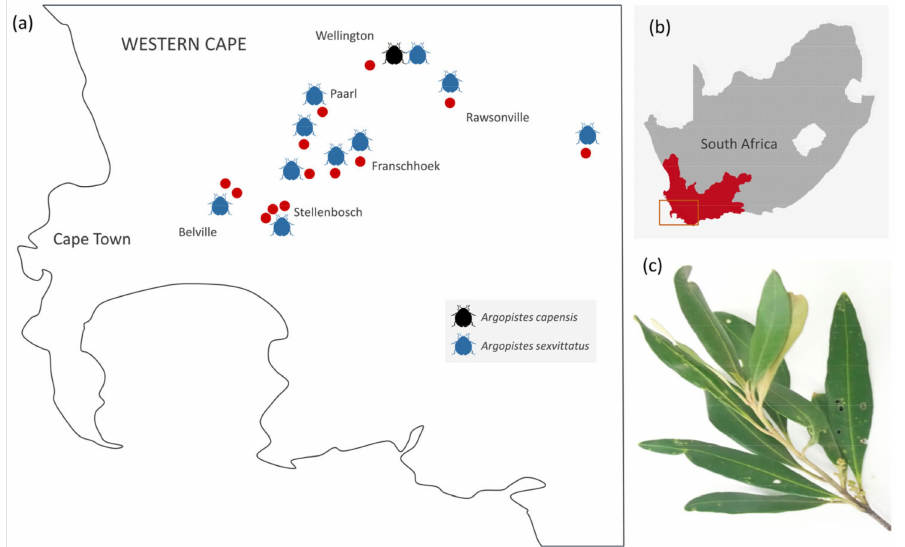
Figure 2. ( a ) Distribution of A. capensis and A. sexvittatus found in African Wild Olive and European cultivated olive trees in the Western Cape province of South Africa. Red dots indicate the approximate location of sampling sites; ( b ) Study area in the Western Cape; ( c ) Characteristic leaf damage caused by feeding of olive flea